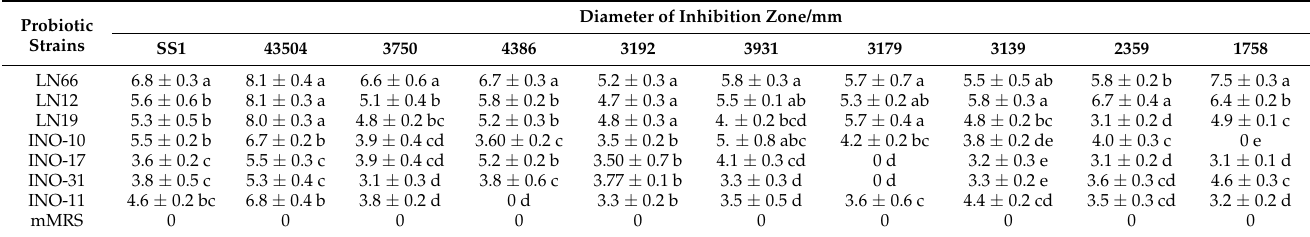
as the means ± standard deviation from three independent experiments. The groups marked with different letters indicate statistically significant differences ( p <